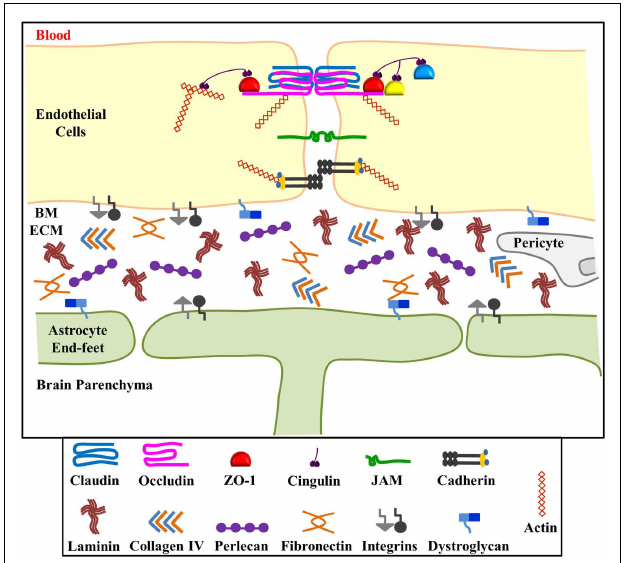
FIGURE 1 | Schematic representation of the blood-brain barrier (BBB). The BBB consists of interendothelial cell tight junctions and adherens junctions, the extracellular matrix components of the basement membrane, pericytes and astrocyte end-feet.The basement membrane extracellular matrix (ECM) components hold endothelial cells and astrocytes in close proximity and contribute to the permeability and stability of the BBB. ECM components include laminin, collagen IV, fibronectin, and perlecan which bind to and signal through integrin ( α and β ) and dystroglycan ( α and β ) receptors located on both endothelial cells and astrocytes. Perlecan, and potentially other ECM components of the BBB, are processed into smaller biologically active fragments upon BBB injury.We hypothesize that these fragments, in turn, might have beneficial effects on brain injury recovery. Figure adapted from Huber et al. (2001) and del Zoppo and Milner (2006).